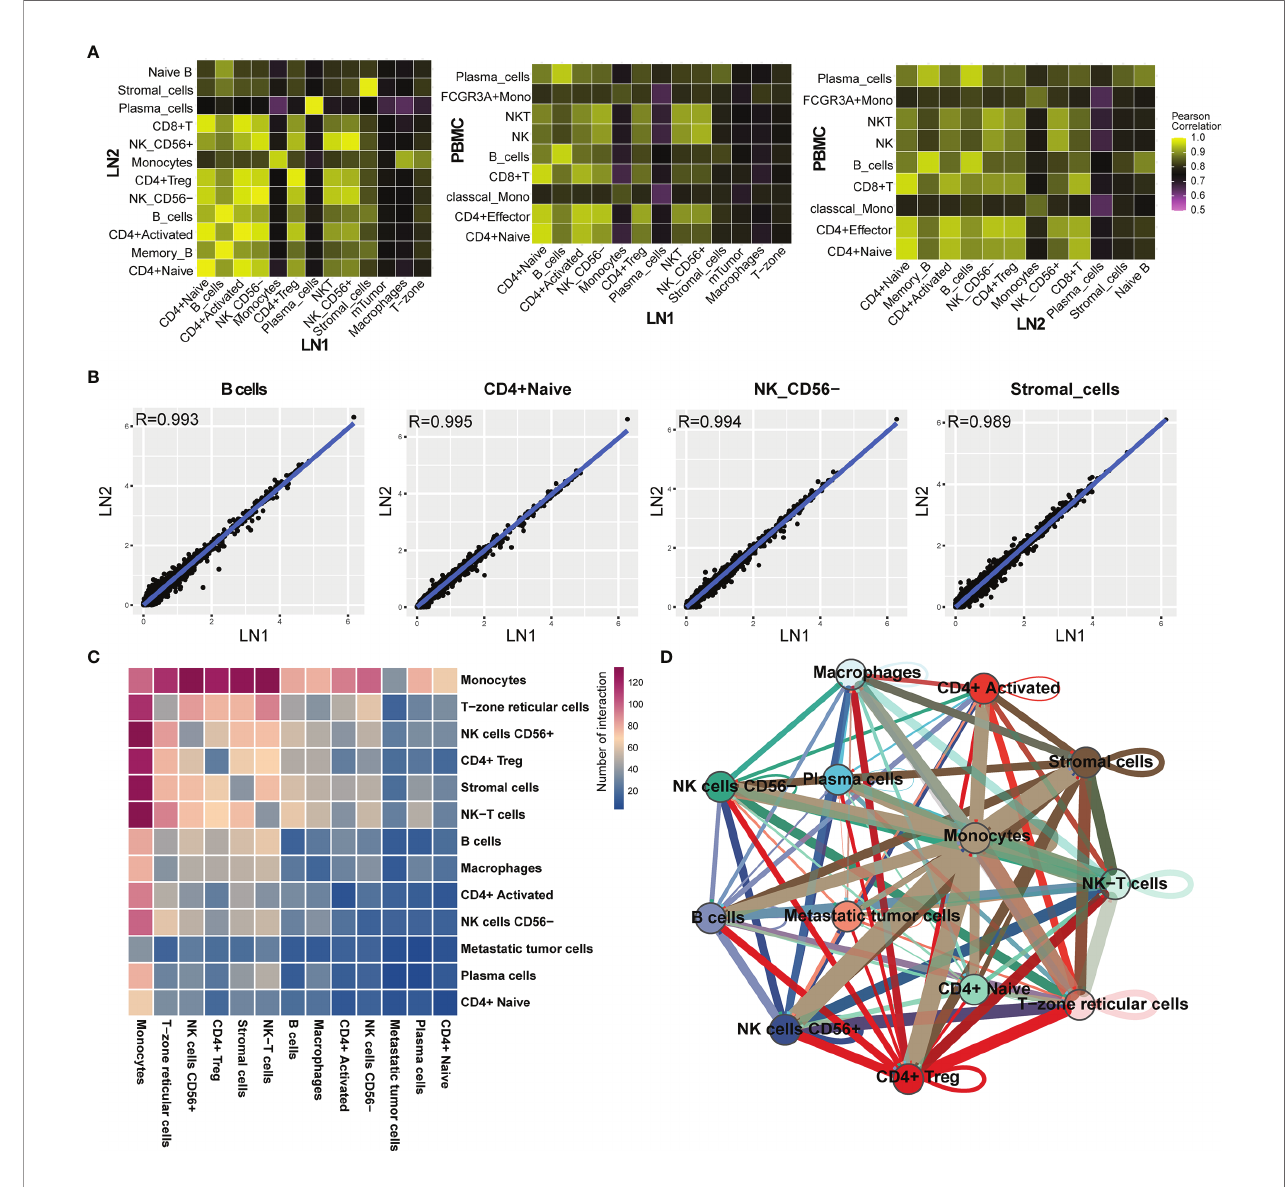
FIGURE 7 | (A) Heat map indicating Pearson correlations on the averaged pro fi les among each cell types for left pelvic lymph node (LN1) and left renal hilus lymph node (LN2) and PBMC. (B) Scatterplot showing the log1p of the average expression per gene of B cells, CD4+ naive T cells, CD56- NK cells and stromal cells in LN1. (C) Ligand – receptor interactions across each cell type in LN1; the colour represents the number of interactions. (D) Analysis of cell-cell communication of each cell type by Cell chat. Nodes represent the cluster, and the line thickness represents number of